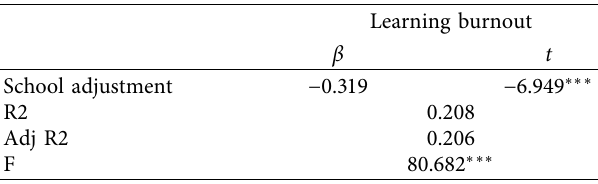
Table 9: School adaptation and learning burnout hypothesis analysis table.